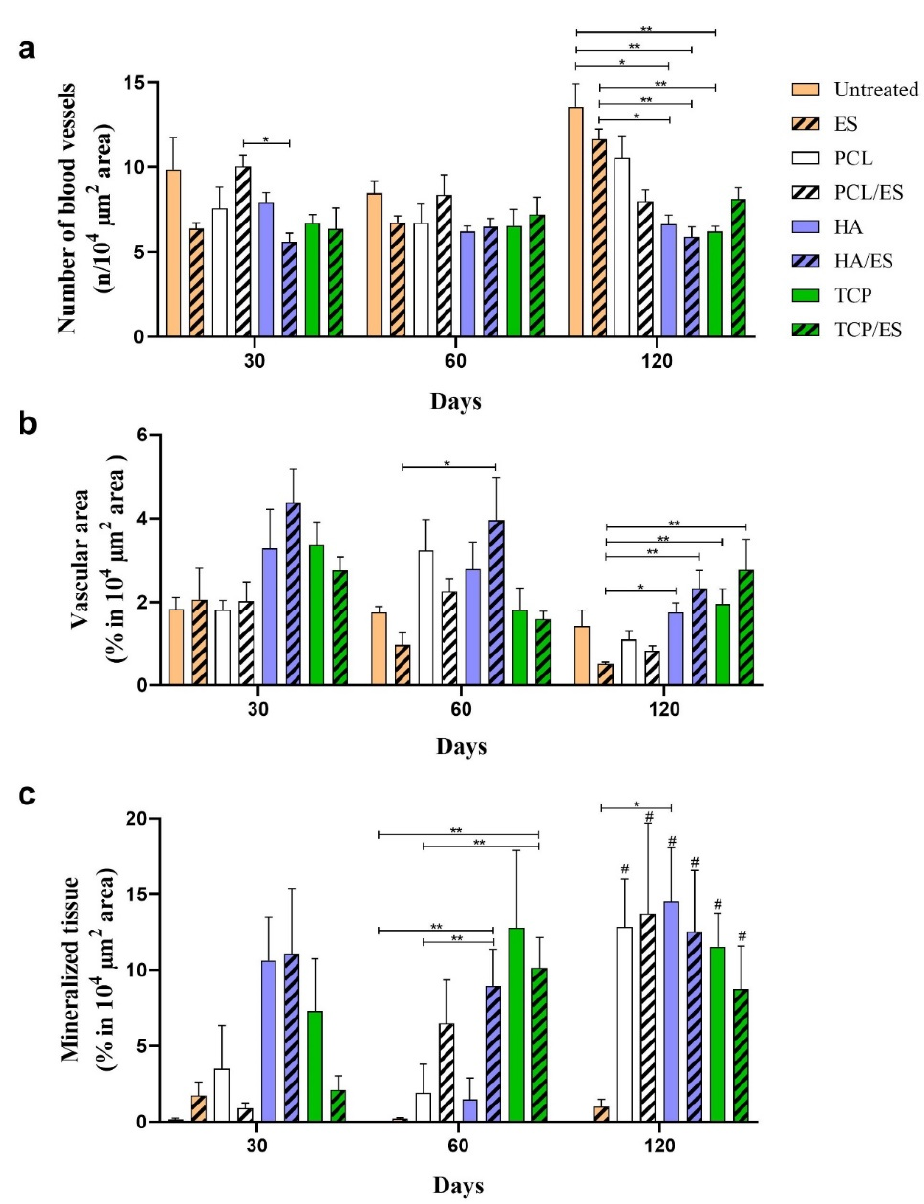
Figure 4. Histological quantification. ( a ) Number of blood vessels presented in 10 4 µ m 2 area of each image of the bone defect; ( b ) vascular area (percentage) in 10 4 µ m 2 area of the bone defect; ( c ) mineralized tissue area (percentage) in 10 4 µ m 2 area of the bone defect. * ( p < 0.05); ** ( p < 0.01); # (statistical difference to untreated group).